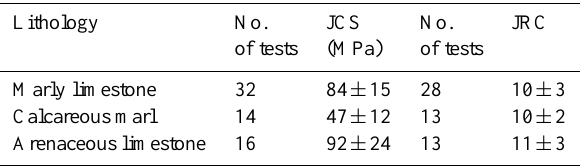
Table 1. Joint Compression Strength (JCS) and Joint Roughness Coefficient (JRC) values of representative lithotypes of the Mt. An- tola limestone. Survey stations are shown in Fig.